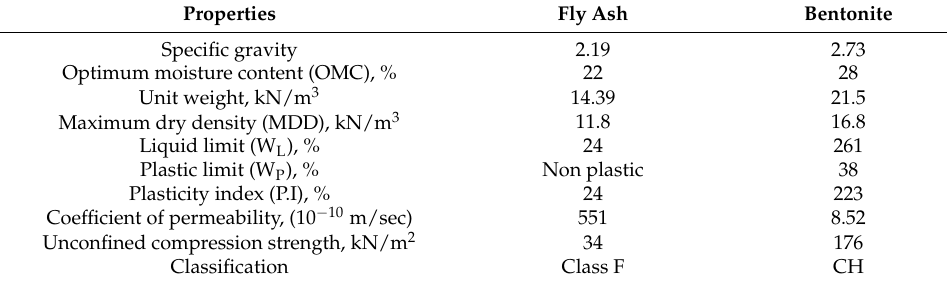
Table 2. Physical properties of fly ash and